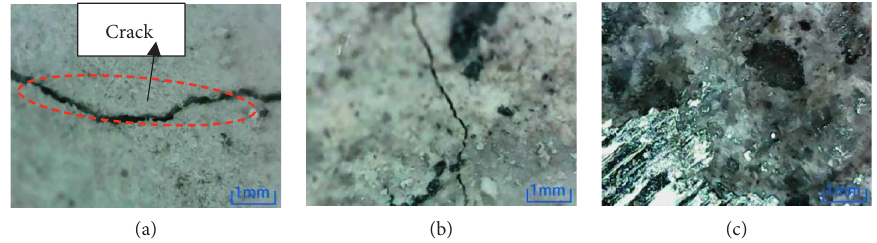
Figure 21: Microscopic observation of position 3 in 100 times freeze-thaw cycles. (a) 0%. (b) 1%. (c) 2%.